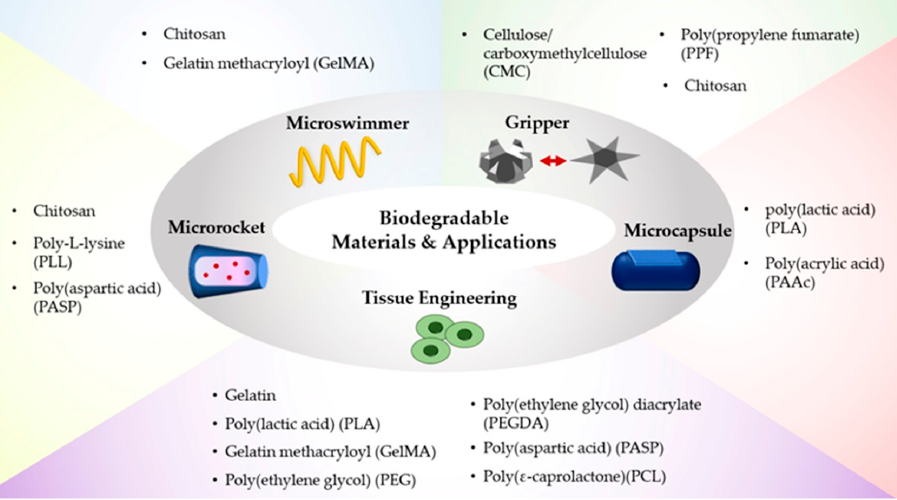
Figure 1. Biodegradable materials and their